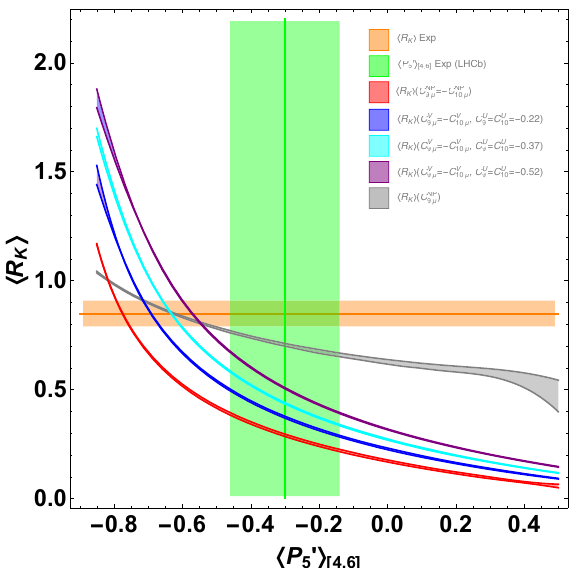
V V V (grey), = (red), 9 µ 9 µ 10 µ C C −C